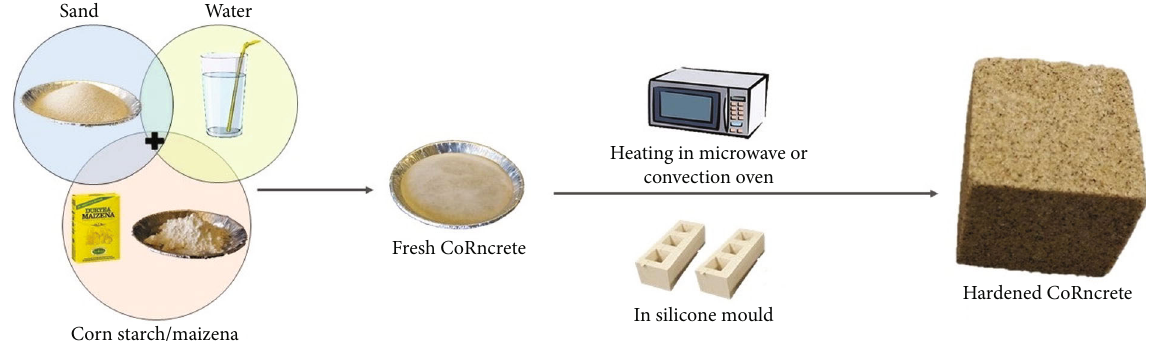
Figure 1: Preparation of hardened CoRncrete by heating a mixture of sand, water, and corn starch in a microwave or a convection oven [32].